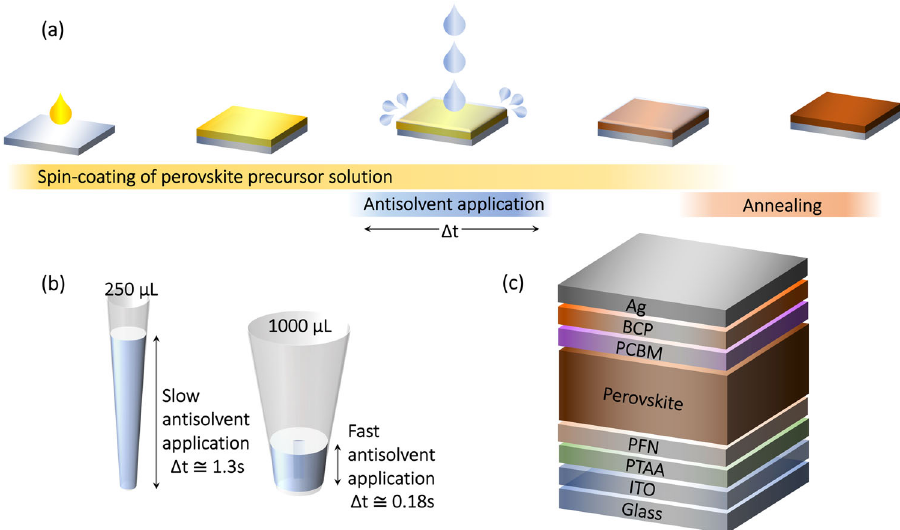
Fig. 1 Deposition process and architecture of perovskite solar cells. a Schematic depiction of the perovskite layer fabrication process. b Illustration of the 1000 and 250 μ L pipettes that were used to adjust the duration of the antisolvent application step. For the same applied force and solvent volume (200 μ L), the extrusion rate is fast for the 1000 μ L pipette and slow for the 250 μ L pipette. c Schematic structure of the photovoltaic devices fabricated in this